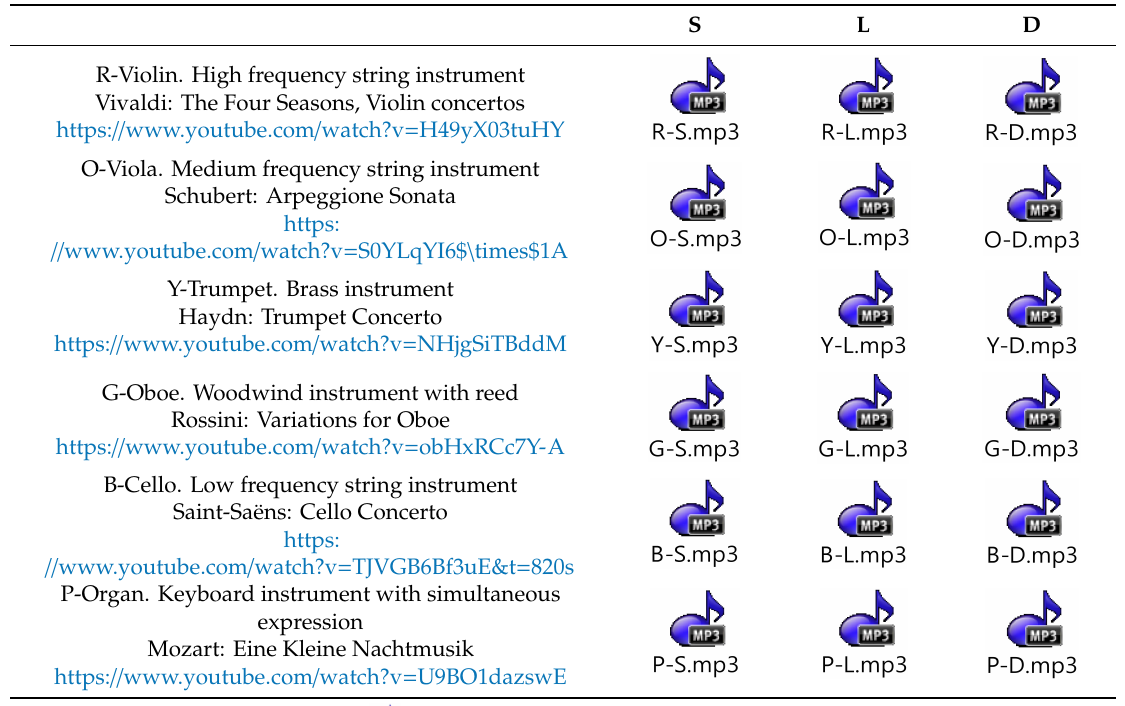
Table 4. CLASSIC SCC